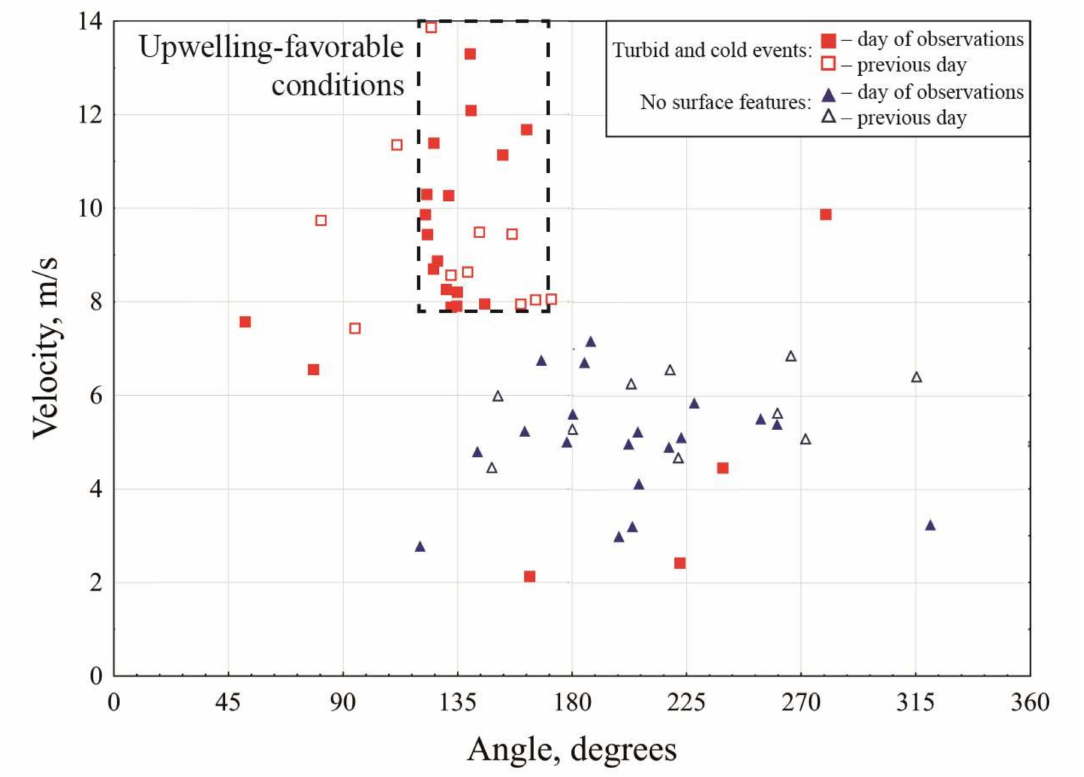
Figure 4. Wind forcing conditions at the Lena Delta region during periods of presence (red squares) and absence (blue triangles) of cold and turbid events detected on satellite imagery. For each satellite image, averaged wind forcing conditions are shown during the day of satellite observation (filled symbols) and during the preceding day (empty symbols). The black dashed rectangle indicates upwelling-favorable wind forcing